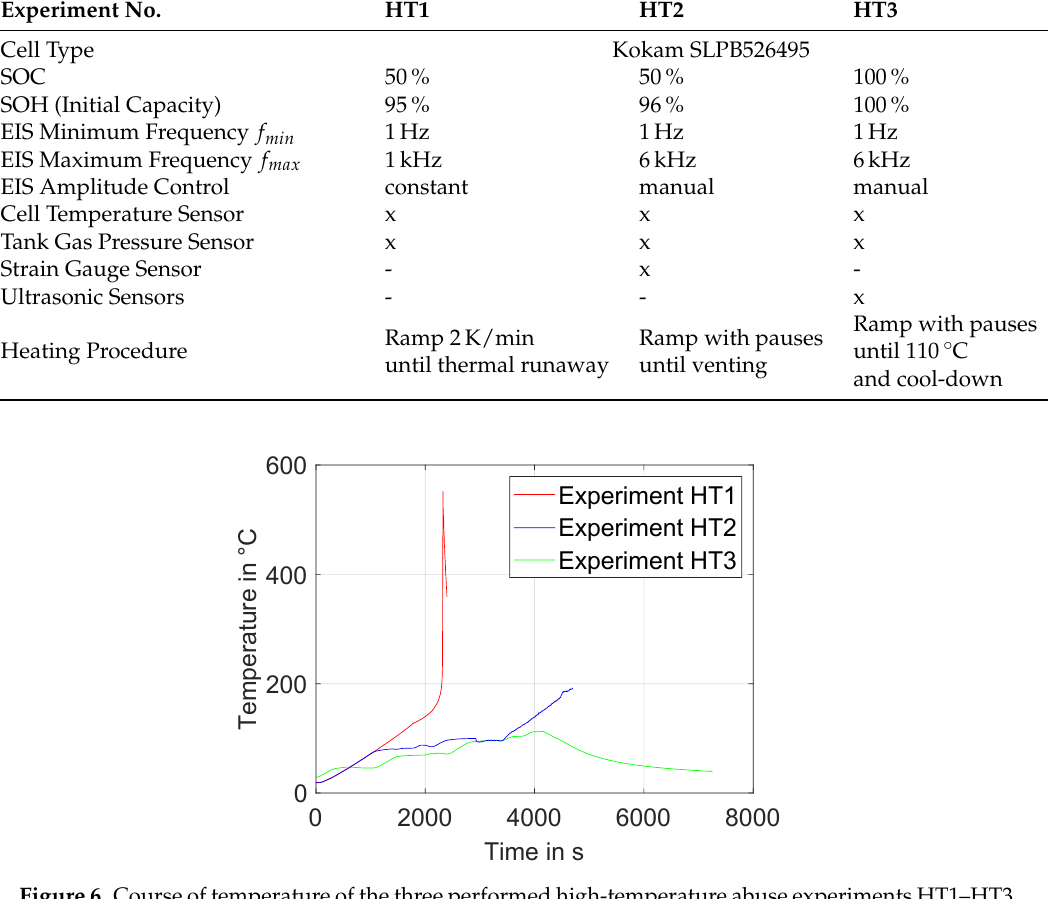
Figure 6. Course of temperature of the three performed high-temperature abuse experiments HT1–HT3. During the heating process continuous EIS measurements with a galvanostatic excitation with constant maximum amplitude in the range from 1 Hz to 1 kHz were performed. the amplitude was set so that the voltage response at room temperature is limited to 10